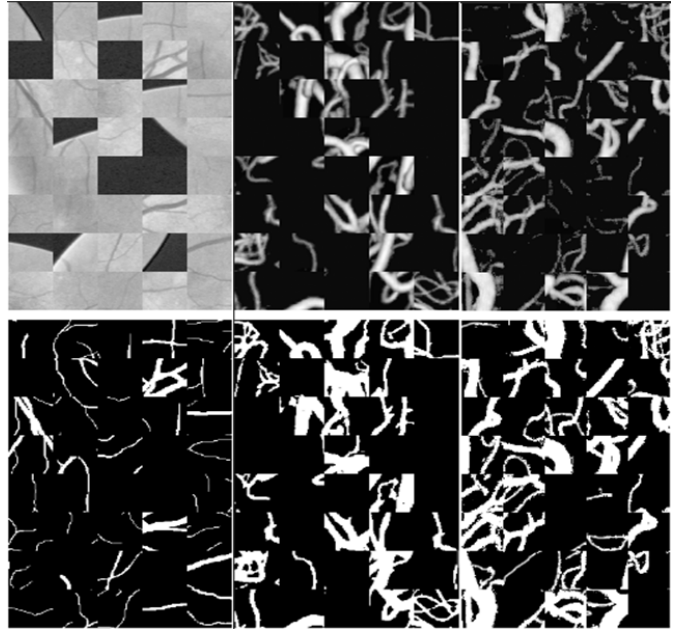
Figure 4. From left to right are the data sets DRIVE,ELE,CORO. Above are patches of the original image, and below are patches of the output